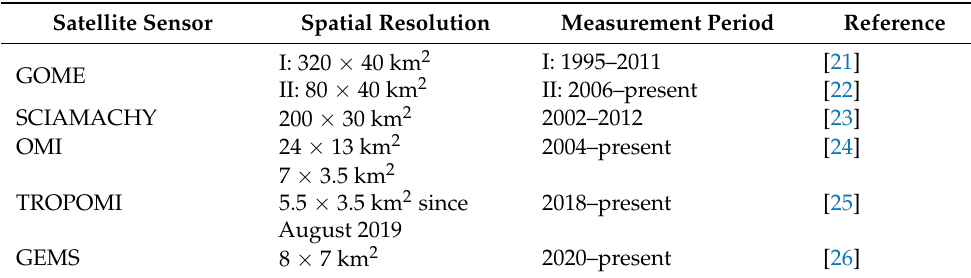
Table 1. Satellite missions to measure atmospheric composition including NO 2 concentrations, and their spatial resolutions, measurement periods, and